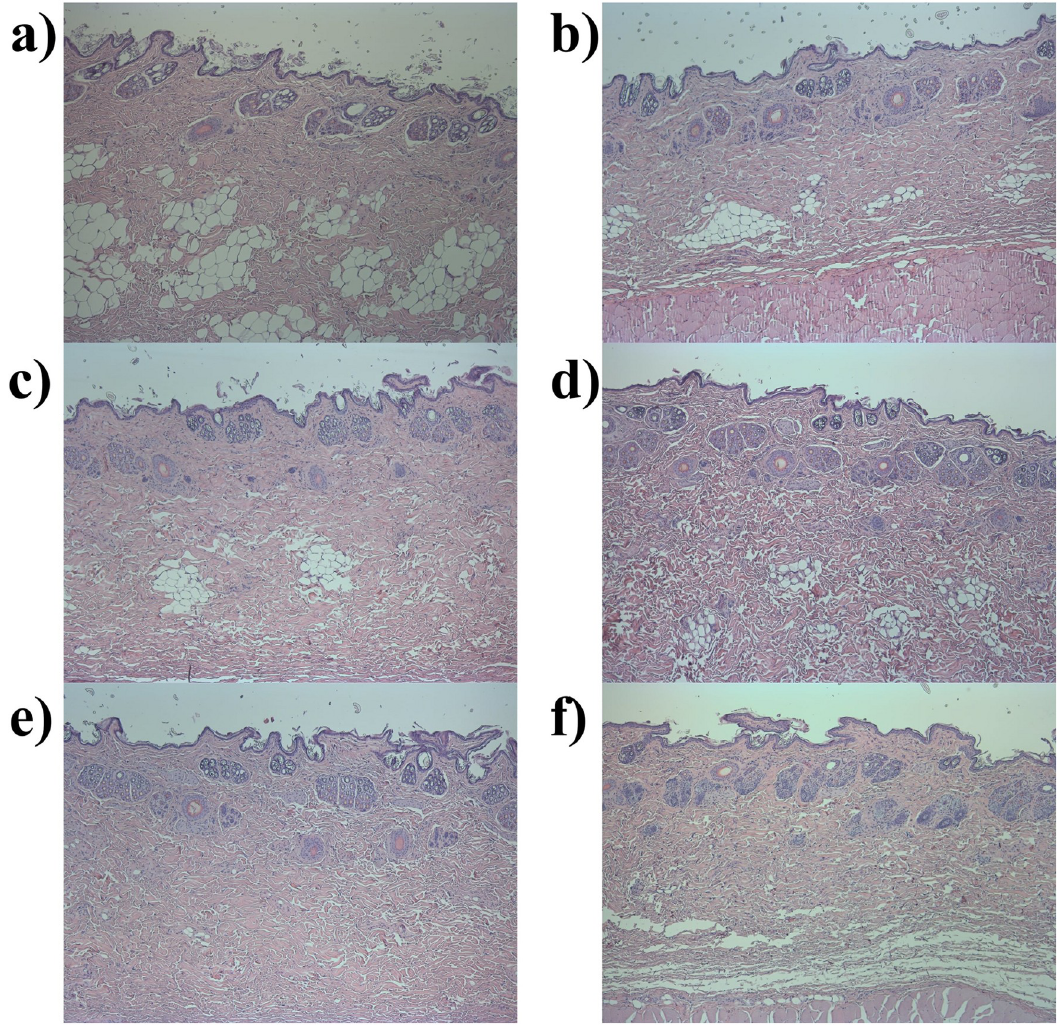
Fig 3. Histopathological section of the administration site in the intradermal irritation study in New Zealand White (NZW) rabbits. Hematoxylin and eosin stained histopathological section (original magnification 50x) of the dorsal back skin of the NZW rabbits: a) Control group; b) Polysorbate 20–0.02 mg/kg; c) Polysorbate 20–0.1 mg/kg; d) Polysorbate 20–0.4 mg/kg; e) Human serum albumin (HSA)-0.06 mg/kg; f) HSA-0.12 mg/kg, male. No histopathological findings were found at the site of administration in all administered